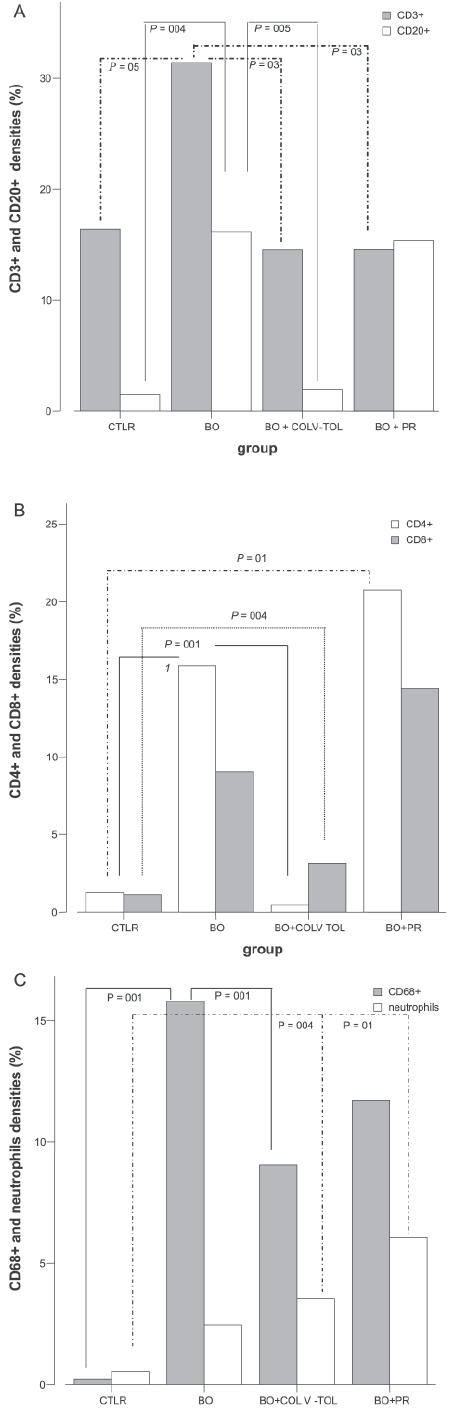
Figure 4 - Quantitative data of densities (%) of CD3 + and CD20+ (A), CD4 + and CD8 + (B), and CD68 + and macrophage (C) immune cells in CTRL, BO, BO+COLV-TOL and BO+PR lungs. Compare CD3 + cells for TB (A) from BO+COLV-TOL and BO+PR to BO animals. CD20 + (A) and CD4 + (B) cells reduced after BO+COLV-TOL, when compared to BO. Note increase in CD8 + cells (B) in animals receiving the BO+COLV-TOL and BO+PR treatments, vs. CTRL. Density of CD68 + cells and neutrophils, increased in BO lungs, did not differ between the BO+COLV-TOL and BO+PR (C). TB- terminal bronchiole, TA- terminal artery; BO- (bronchiolitis